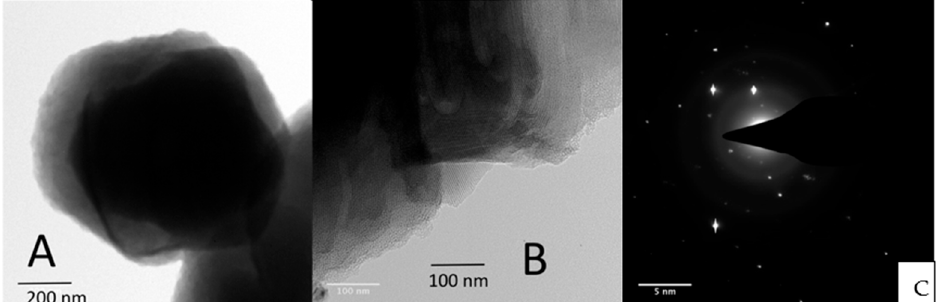
Figure 2. ( A ) and ( B ): HRTEM micrographs of brominated COF 4 , ( C ): diffraction of COF 4 . Enlarged images of A and B are included in the Supplementary Materials as Figures S7 and S8.